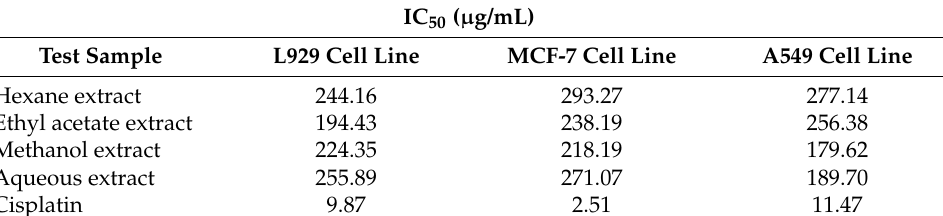
Table 4. Cytotoxicity of different solvent extracts of T. terrestris against different cell lines.